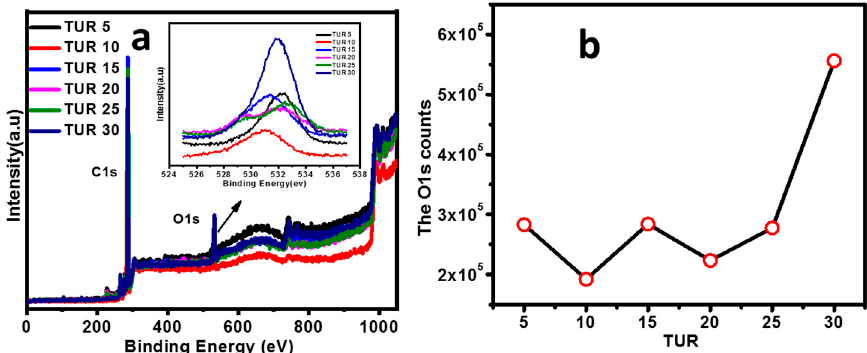
Figure 4. ( a ) Surface composition survey by XPS scans at various TURs; ( b ) calculation of percentage atomic concentration of functional group by O 1s peaks.